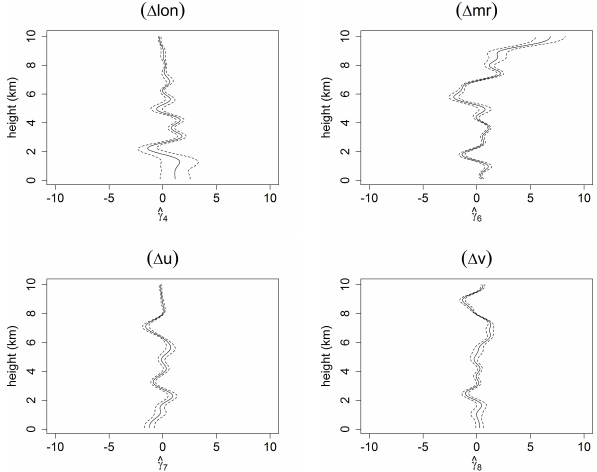
Fig. 6. Gamma functions of collocation error ω 2 for relative humidity in Beltsville using model (15) . Top left: Sterling pressure (cid:0) p 0 (cid:1) ; top right: Sterling temperature (cid:0) T 0 (cid:1) ; bottom left: Sterling relative humidity (cid:0) rh 0 (cid:1) ; bottom right: difference in pressure (∆ p ) . Figure 1 of 2. Fig. 7. Gamma functions of collocation error ω 2 for relative humidity in Beltsville using model (15) . Top left: difference in longitude (∆ lon ) ; top right: difference in mixing ratio (∆ mr ) ; bottom left: difference in wind, u-direction (∆ u ) ; bottom right: difference in wind, v-direction (∆ v ) . Figure 2 of 2.